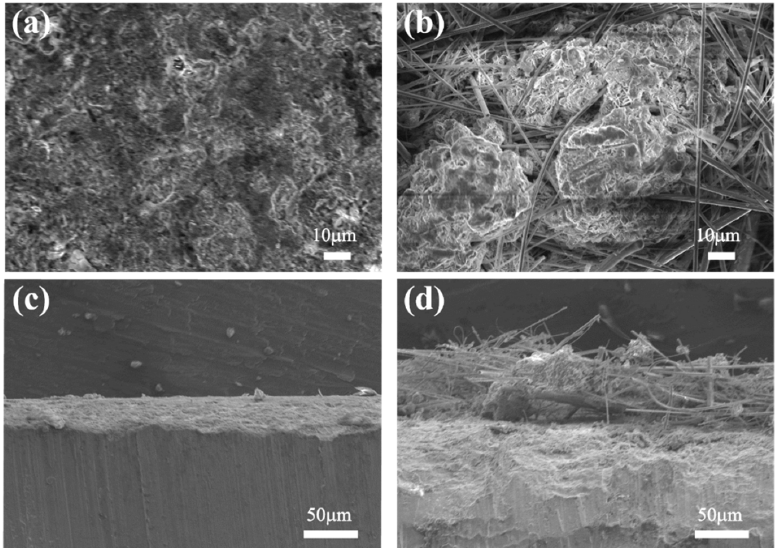
Figure 10. The surface morphology of Zn after 300 cycles in ( a ) Zn/GPE/LFP and ( b ) Zn/LE/LFP; the cross ‐ sectional morphology of Zn after 300 cycles in ( c ) Zn/GPE/LFP and ( d ) Zn/LE/LFP.